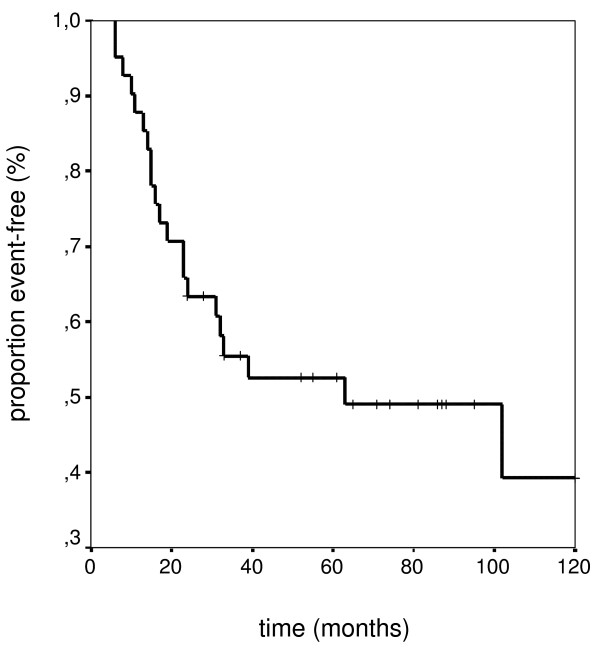
Overall survival of the entire collective (n = 41).